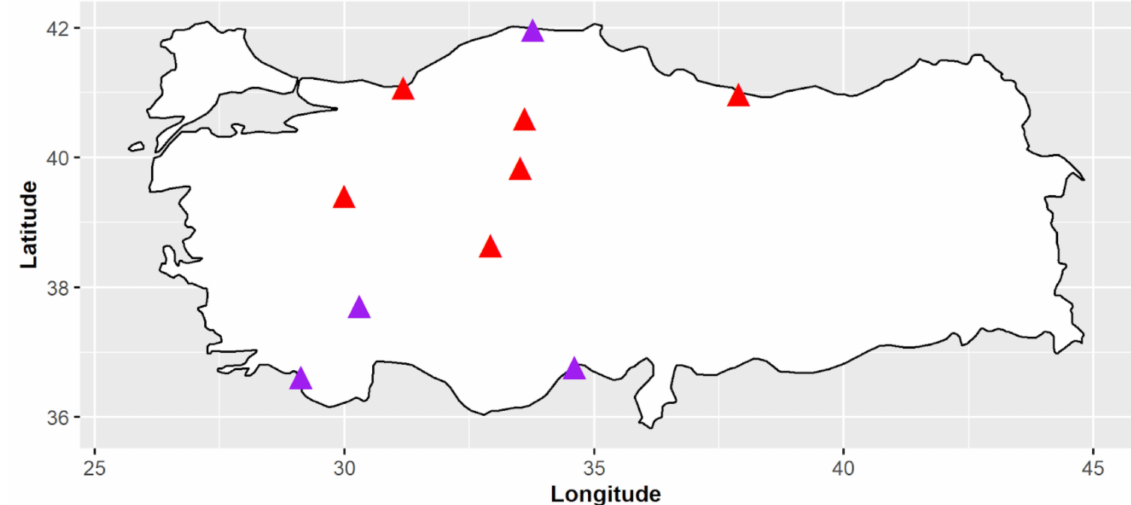
Figure A17. Same as Figure A13 but for April (See Figure A13 for legend).